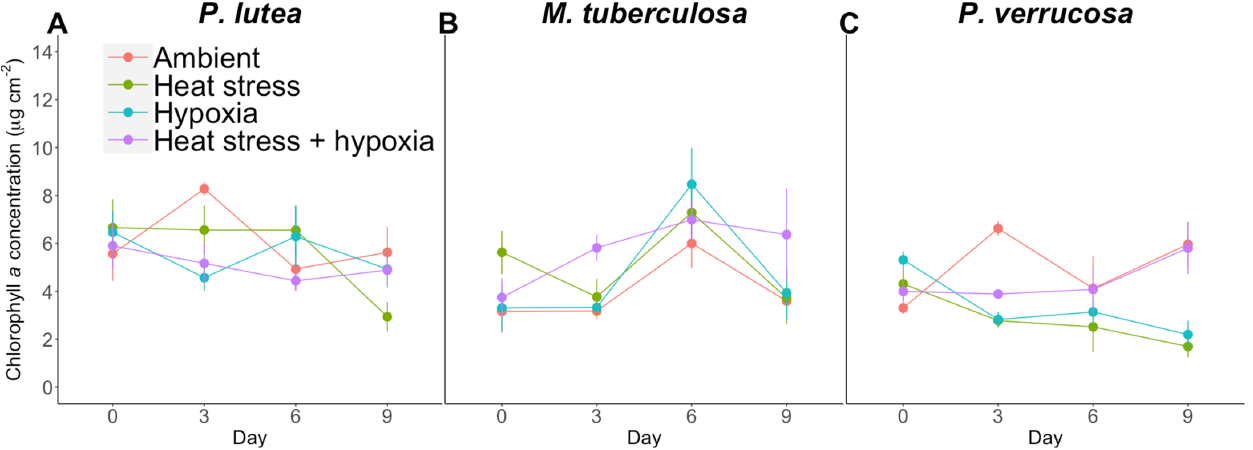
Figure 5. Chlorophyll a and c 2 concentration (µg cm − 2 ) of P. lutea ( A ), M. tuberculosa ( B ), and P. verrucosa ( C ) under ambient conditions, heat stress, hypoxia, and heat stress + hypoxia on days 0, 3, 6, and 9. Data are shown as mean ± SE ( n = 4).